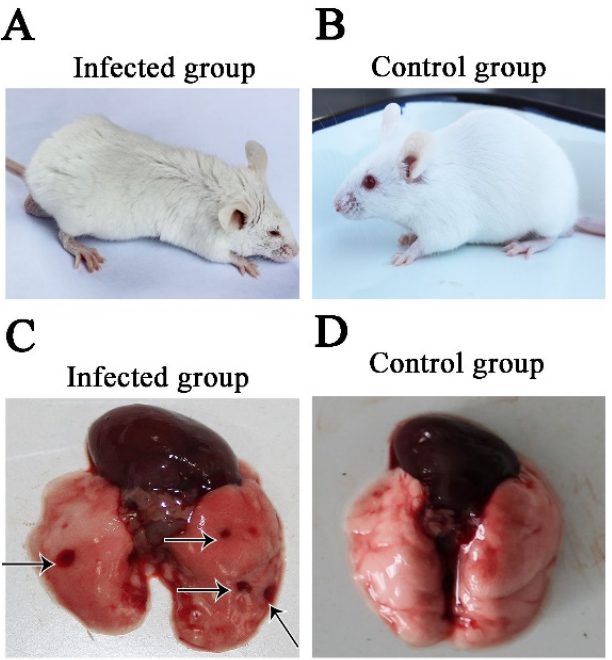
Figure 1. Clinical and Necropsy Findings . Twenty-four specific pathogen-free mice were randomly allocated to two groups (group 1 was a control, and group 2 was inoculated intranasally with EHV-8). Clinical signs of the EHV-8 infected group ( A ) and control group ( B ) were monitored for 7 days. The pathological changes in mice lungs were observed by necropsy findings at 6 dpi. ( C ) Hemorrhage lesions (Arrows indicated) in the lung of the EHV-8 infected group, and ( D ) normal lung lesions of the control group.